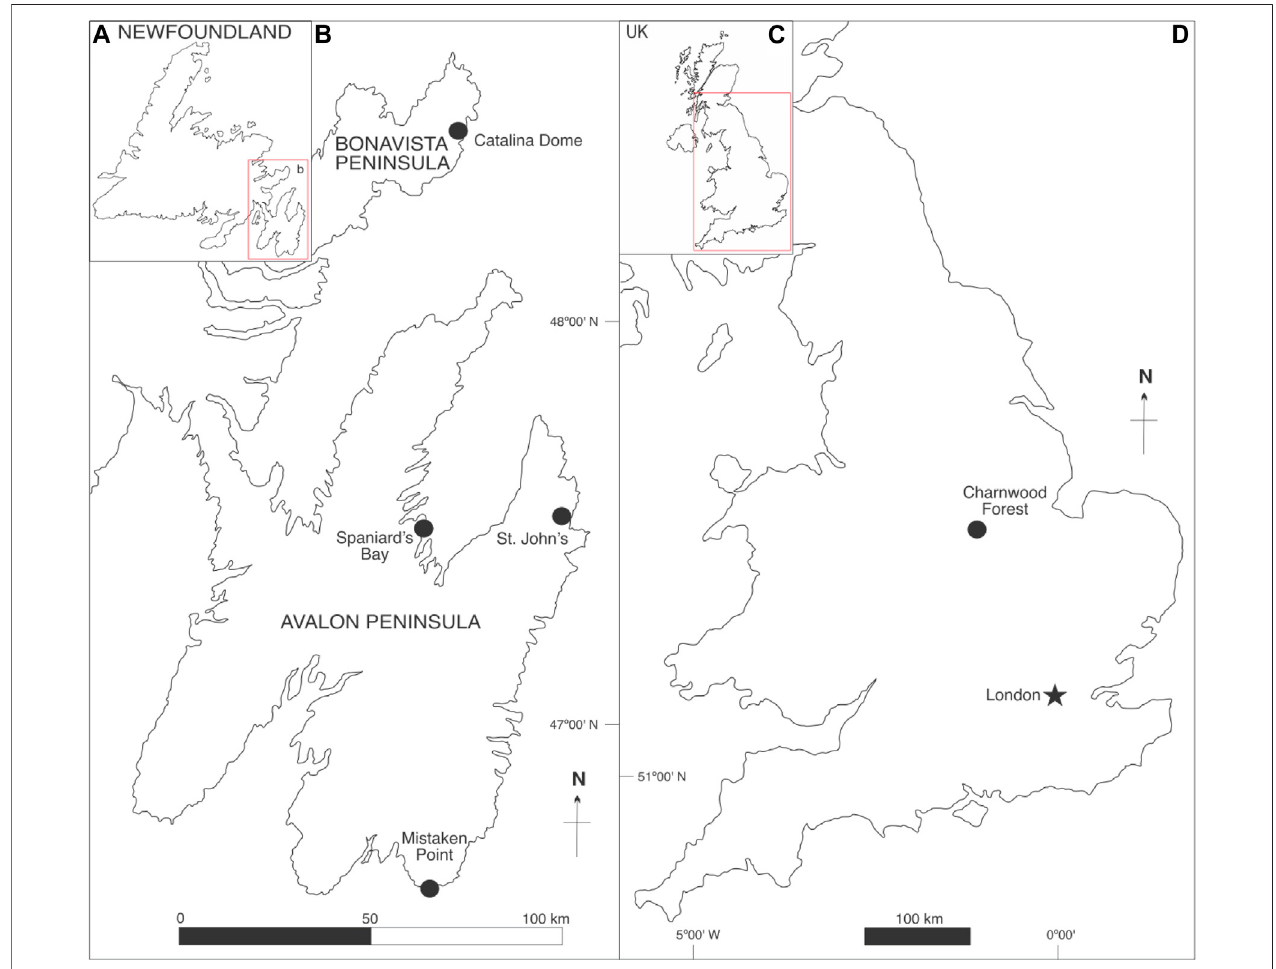
FIGURE 1 | Map of some of the most relevant Avalonian fossil assemblages (black circles). (A) General map of Newfoundland, Atlantic Canada. (B) Detail of the Avalon and Bonavista Peninsulas. (C) General map of the United Kingdom. (D) Detail of England.